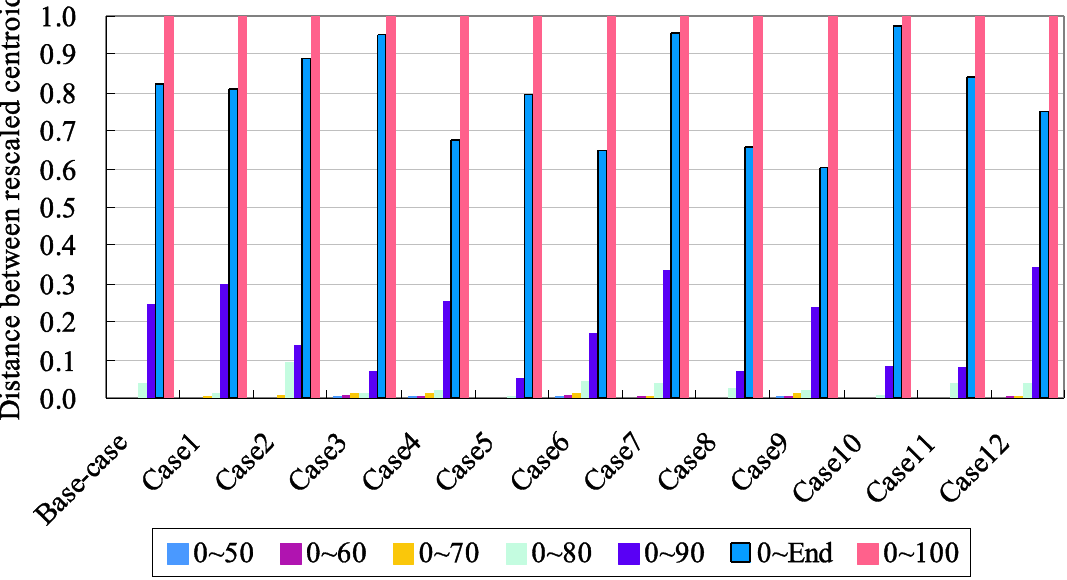
Figure 5. Accumulated distances of the rescaled centroids from the beginning of recovery to different stages of head recovery for different homogeneous cases.